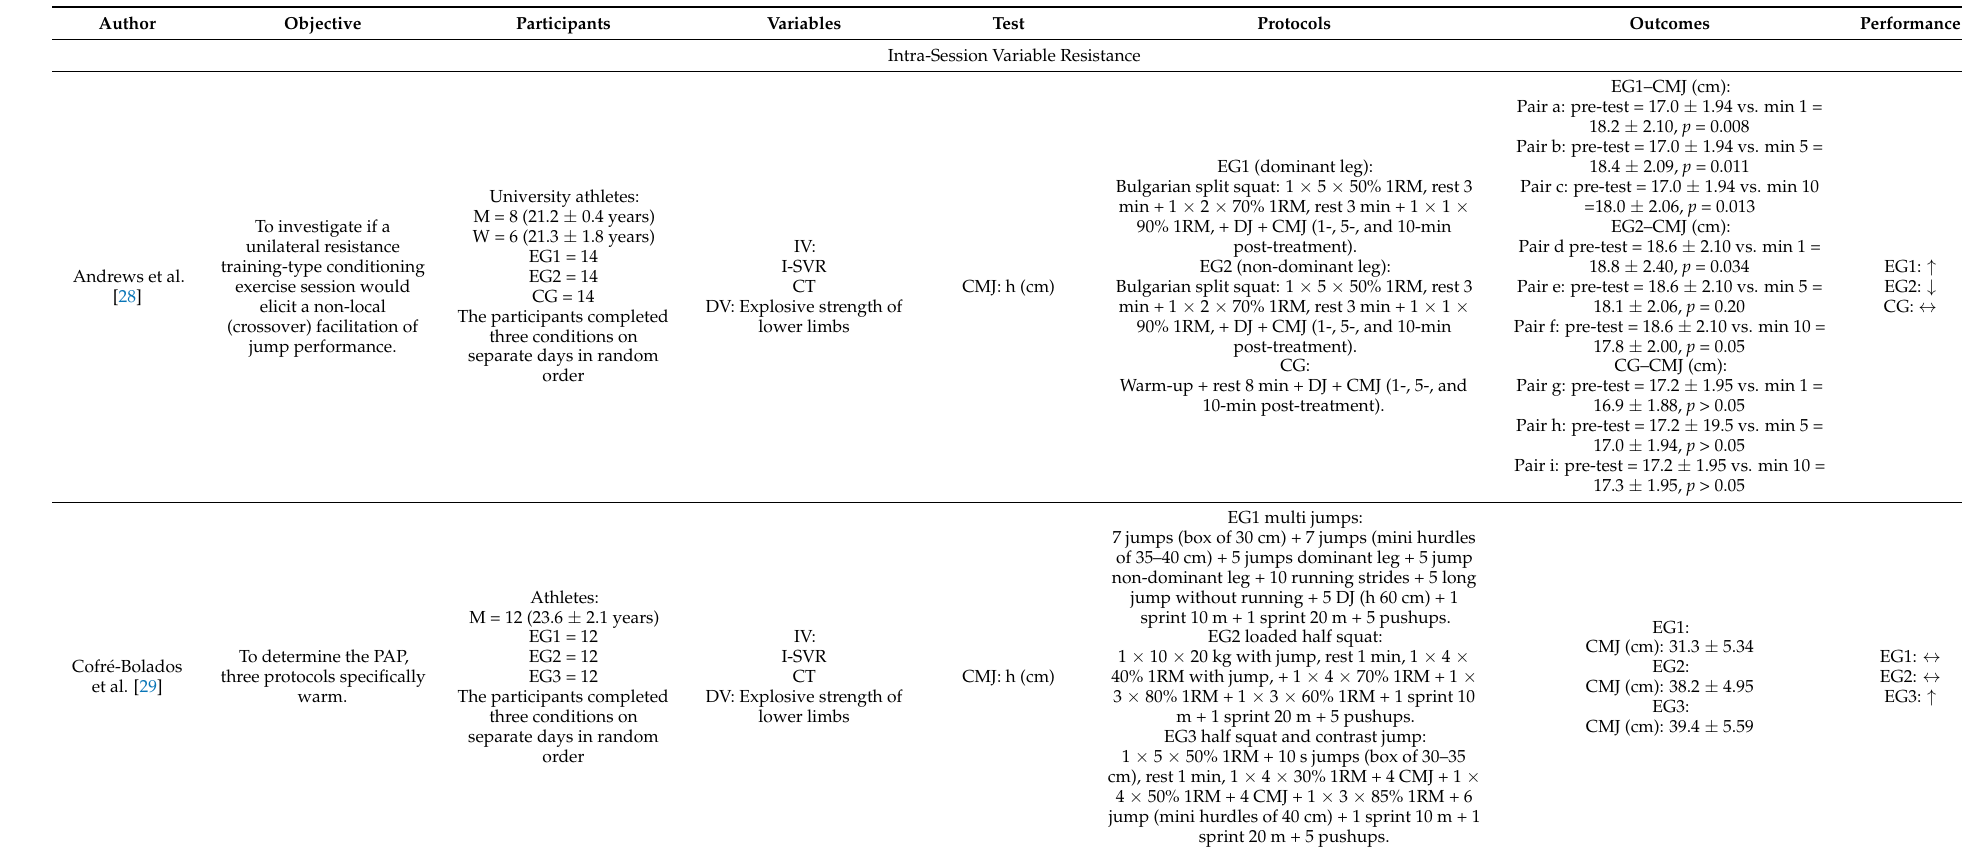
Table 1. Characteristics of the studies that connect VR with